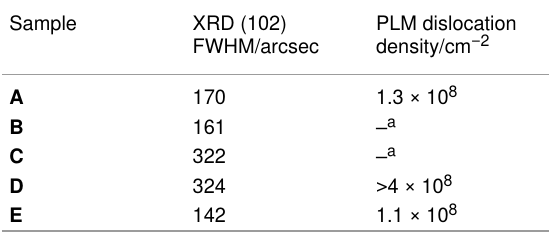
Table 2: XRD FWHM of the (102) reflections determined from epitaxial layers A – E and PL dislocation densities determined from 5 sampling areas on PLM images by manual